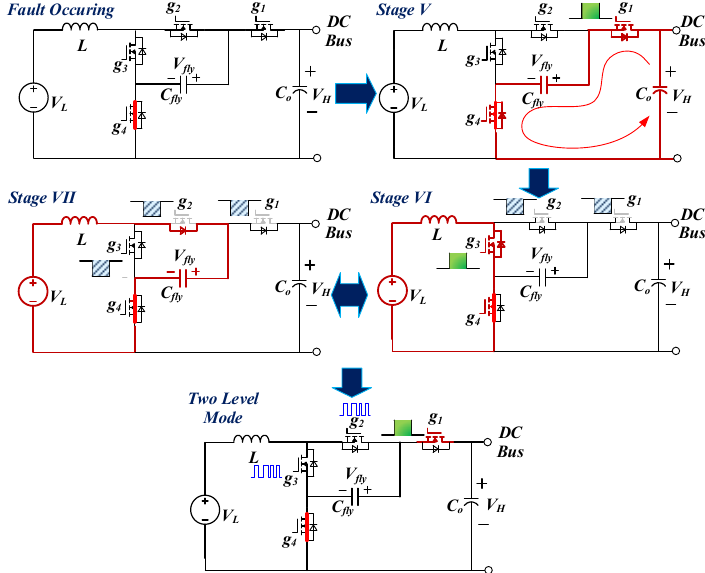
Figure 9. Stages of S 4 short-circuited.